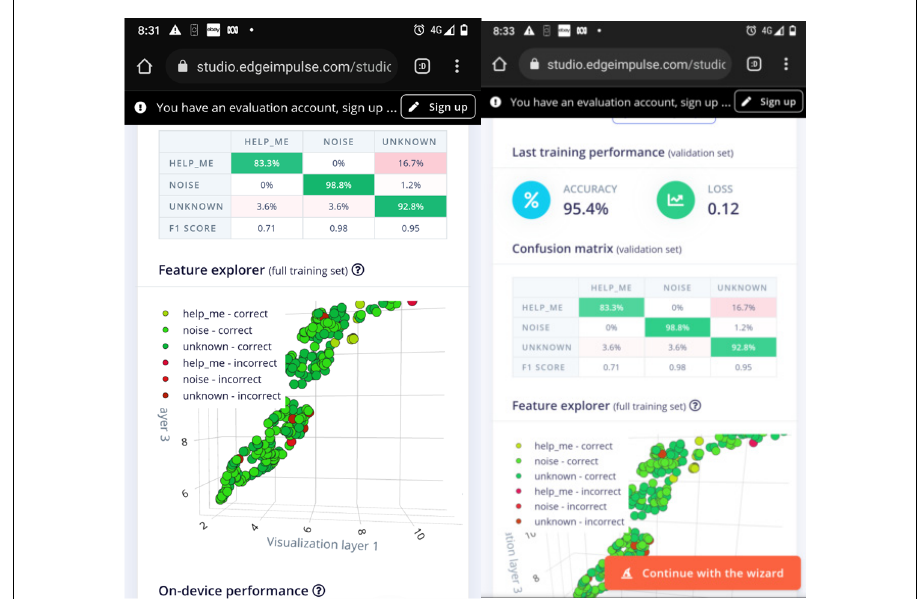
Figure 16. “ Wake word” planning, configuration, tests and results.